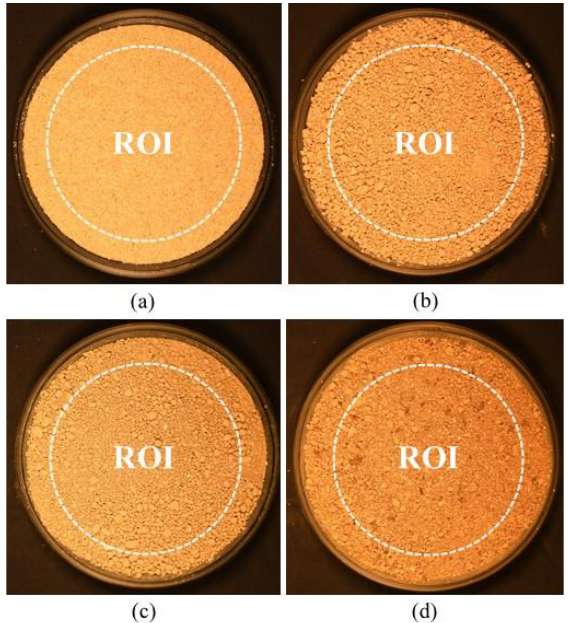
Figure 7. Region of interest (ROI) in digital image analysis: ( a ) Jumunjin sand, ( b ) Anseong soil, ( c ) Yongin soil, and ( d ) Gwanak soil.